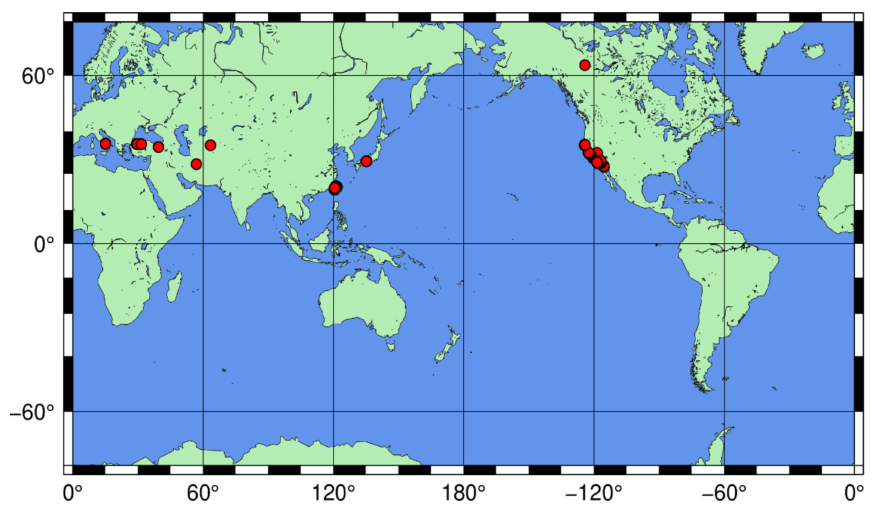
Figure 3. Station distribution of selected pulse-like ground motions.